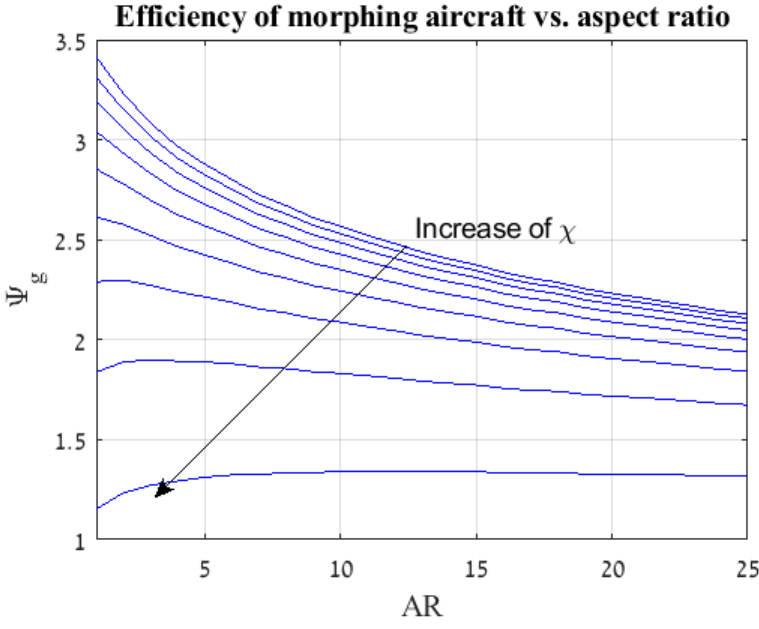
Figure 8. Morphing efficiency over standard glider vs. aspect ratio.